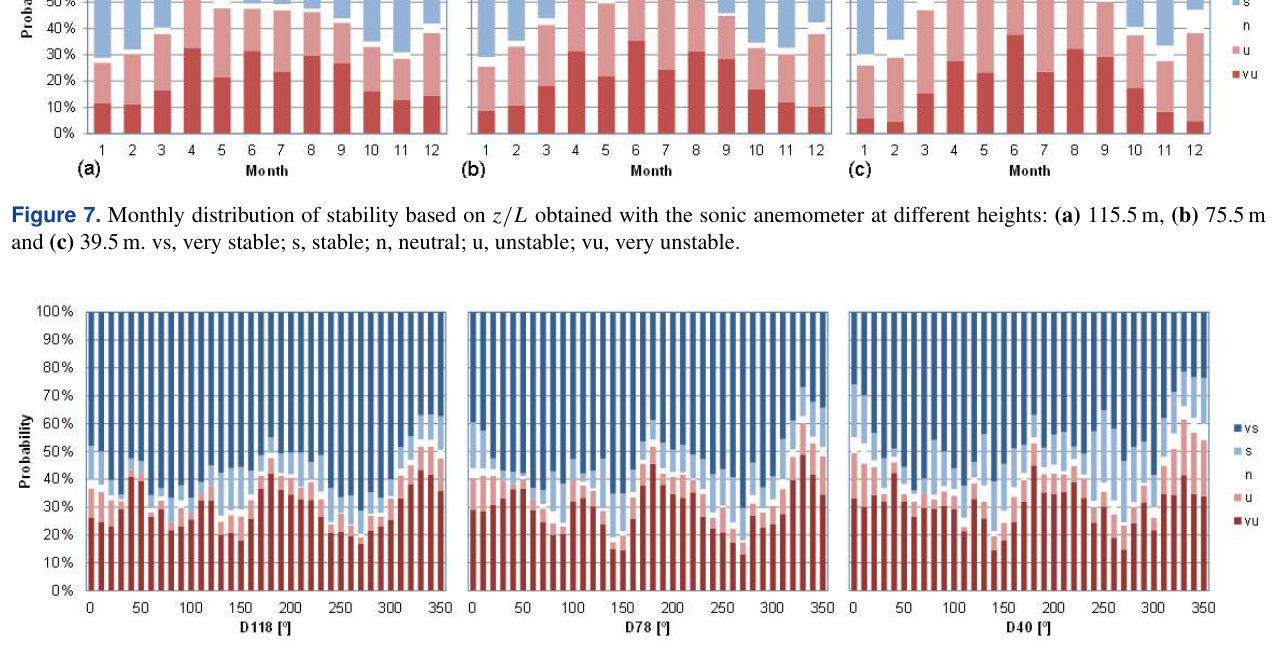
Figure 8. Distribution of atmospheric stability with wind direction based on z/L obtained with the sonic anemometer at different heights. vs, very stable; s, stable; n, neutral; u, unstable; vu, very unstable.